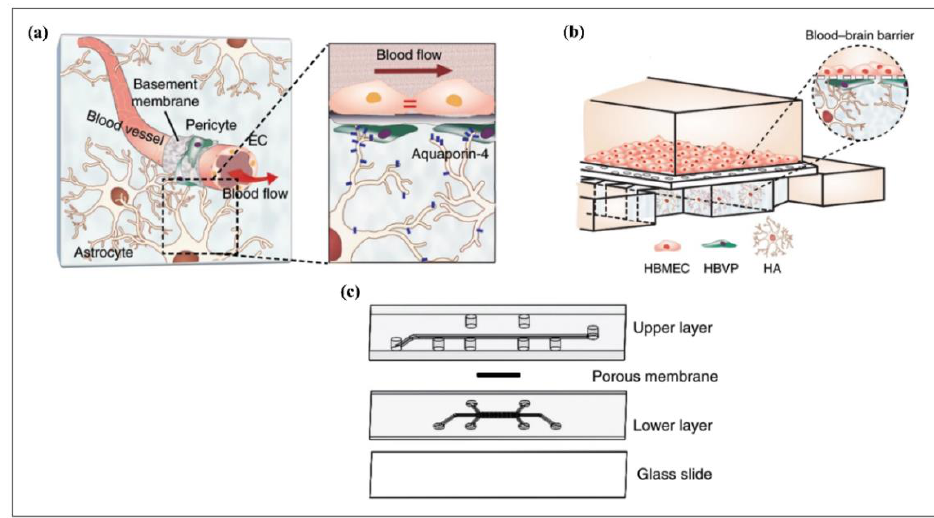
Figure 15. Schematic of human BBB chip presented by Ahn et al. to reproduce the essential structure and function of human BBB and to investigate nanoparticle distribution in the vascular and perivascular parts. ( a ) The figure shows the structure of the BBB composed of endothelial cells (ECs), pericytes, and astrocytes with aquaporin-4 (AQP4) expression. ( b ) Illustration for microengineered human BBB platform. ( c ) Layer-by-layer schematic of developed BBB platform indicates the upper vascular layer, porous membrane, lower perivascular layer, and glass slide. Reprinted from ref. [385] (open access).